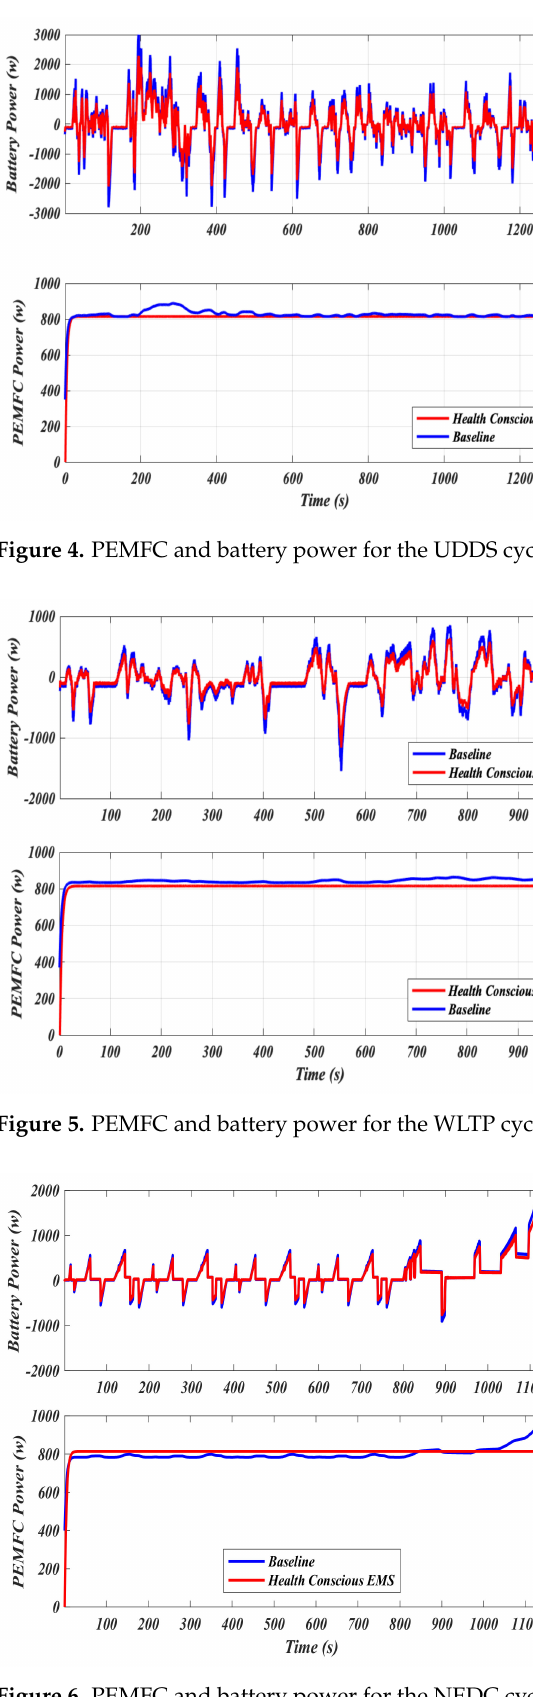
Figure 6. PEMFC and battery power for the NEDC